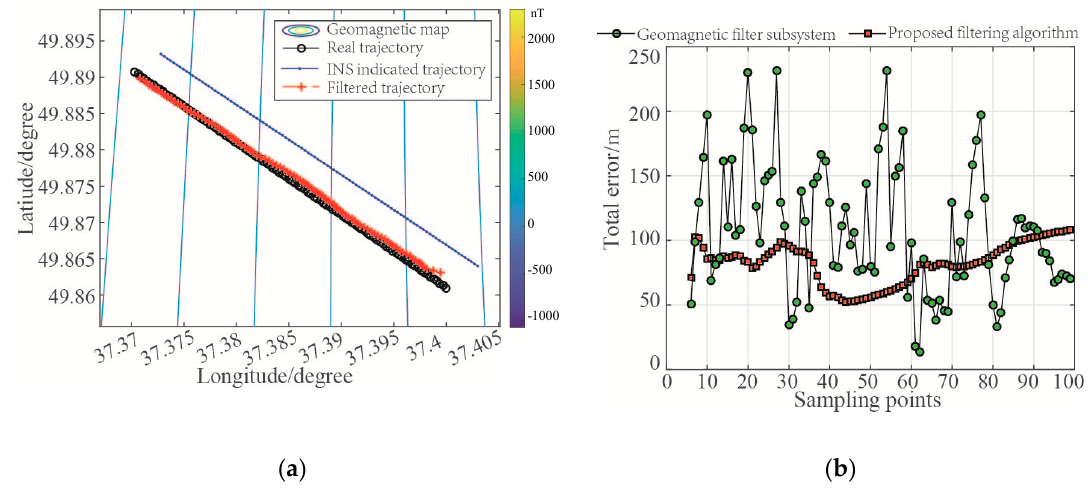
Figure 10. Filtering results of the integrated navigation system: ( a ) Filtering trajectory of the integrated system; ( b ) Total error of the integrated system.